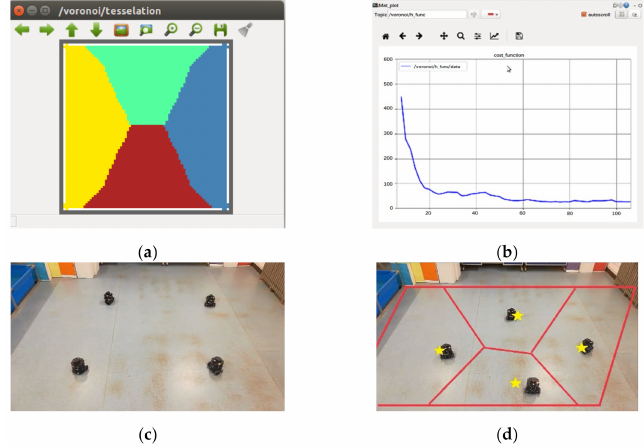
Figure 18. Diamond formation experiment: ( a ) density function distribution; ( b ) cost function; ( c ) initial position; ( d ) final position.